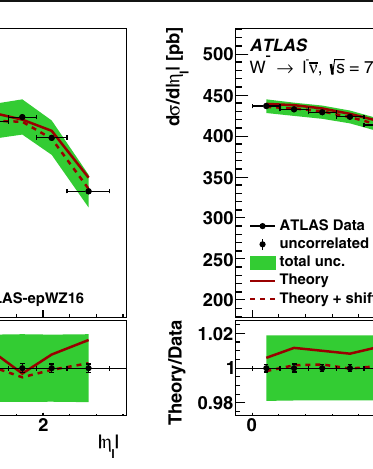
lines ) the shifts due to the correlated uncertainties are applied. The lower box of each plot shows the ratio of the theoretical calculations to the